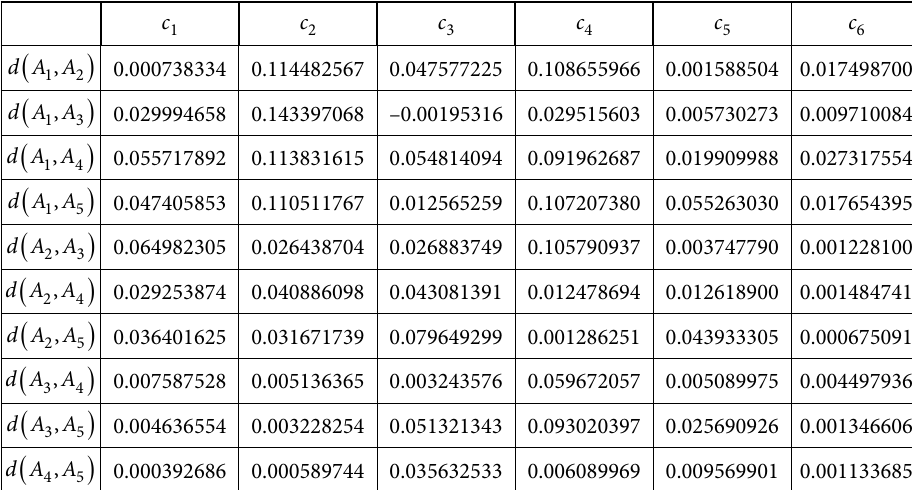
Table 7. Distances between A i and A